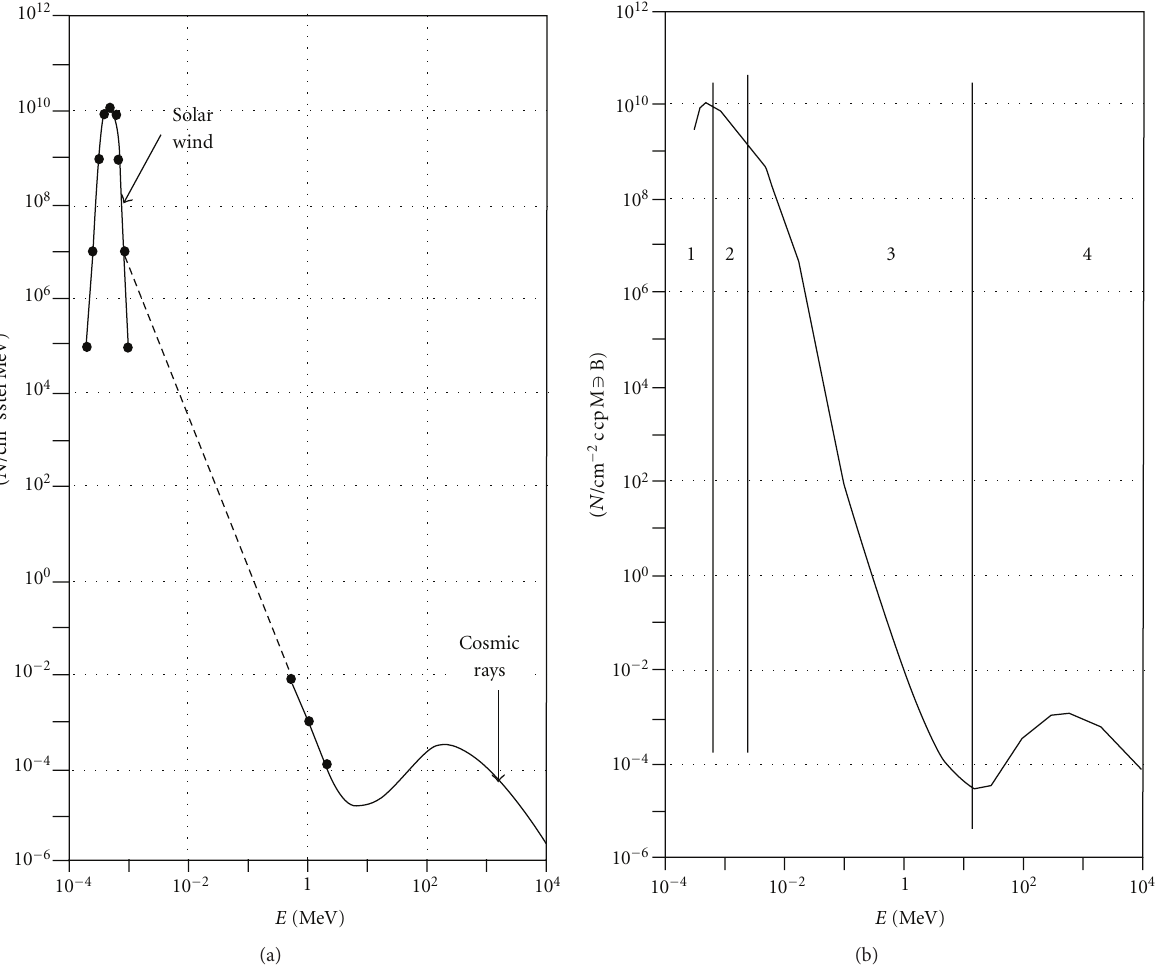
Figure 15: Energy spectra of protons at 1 AU during quiet Sun according to understanding in 1970s (a) and at present (b). 1: solar wind, 2: suprathermal particles, 3: energetic particles of solar origin, 4: galactic cosmic rays. One of the tasks of the Prognoz-3 satellite consisted of measurements of particle flux at energies as close as possible to the energies of solar wind particles. The experiment conducted allowed to measure spectra during the quietest periods within the active interval of Prognoz-3. Energy spectra were measured down to 30keV and the minimum of the proton flux was found. Presently it is clearly confirmed that there are no peculiarities in the energy spectra of particles in the energy range between energetic particles ( < 1MeV) and solar wind. The energy spectra of protons measured in quiet time period of the Sun according to recent observations are shown in